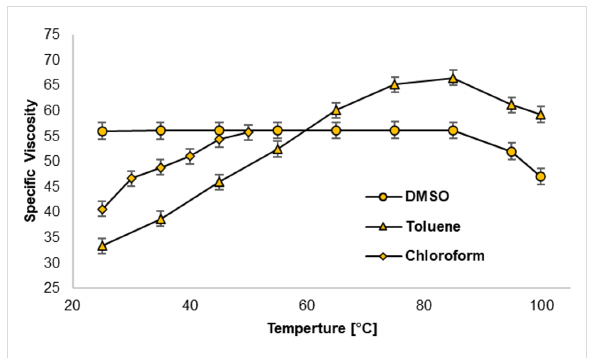
Figure 5: Comparison of the specific viscosities in dependence of the temperature of the ACP derivative (orange) in three different solvents at a concentration of 60